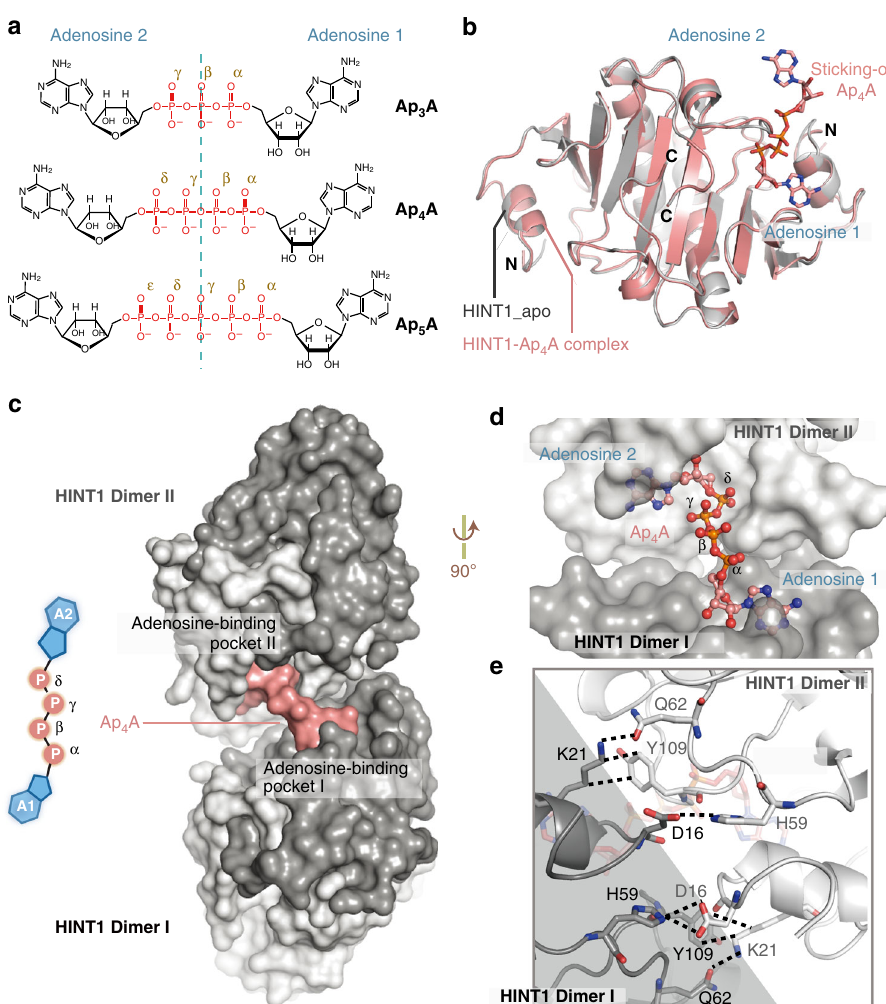
Fig. 1 Ap 4 A integrated two HINT1 dimers into a HINT1-Ap 4 A-HINT1 structure. a Schematics of adenosine polyphosphates (Ap n A). Ap n A is composed by two adenosine moieties linked through ribose 5 ′ -carbons to a phosphate group chain of different length ( n denotes the number of phosphate groups). b Superimposition of the HINT1-Ap 4 A complex structure (pink) and HINT1_apo structure (PDB: 1KPB, gray). c Two HINT1 dimers (Dimer I and Dimer II) were integrated into a tetramer in the HINT1-Ap 4 A complex structure. HINT1 proteins are shown as surface in black or white, and the Ap 4 A molecule is shown as pink surface. d A new cleft built by two adenosine pockets with a long groove accommodated the Ap 4 A molecule. The HINT1 proteins are shown as surface and the Ap 4 A molecule is shown as sticks. e Zoom-in view of the Ap 4 A-induced tetramer interface between HINT1 Dimer I (black) and Dimer II (white). The interacting residues are shown as